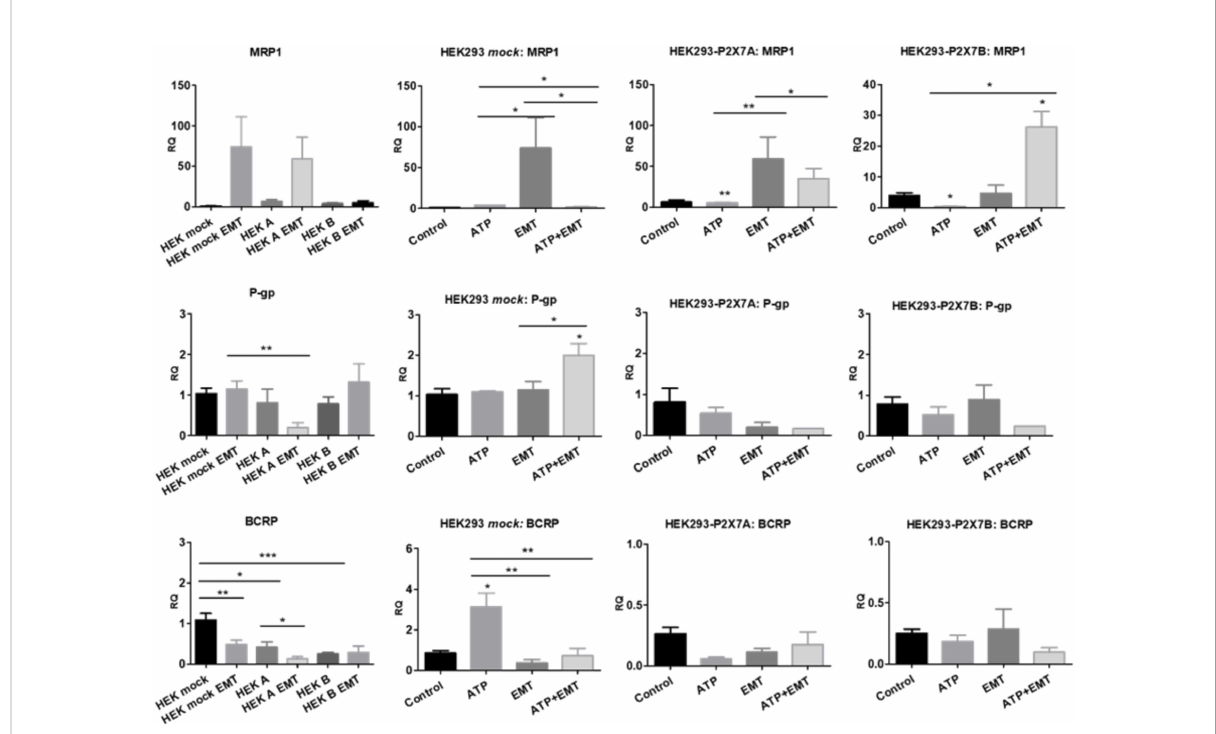
FIGURE 9 Contributions of P2X7 receptors and EMT to ABC transporter expression. mRNA expression levels of MRP1, P-glycoprotein (P-gp) and BCRP in HEK 293 cells treated or not treated with ATP and/or EMT inducers (EGF 50 ng/ml + TGF- b 5 ng/ml) (n>=3). * p <0.05; ** p <0.01; *** p